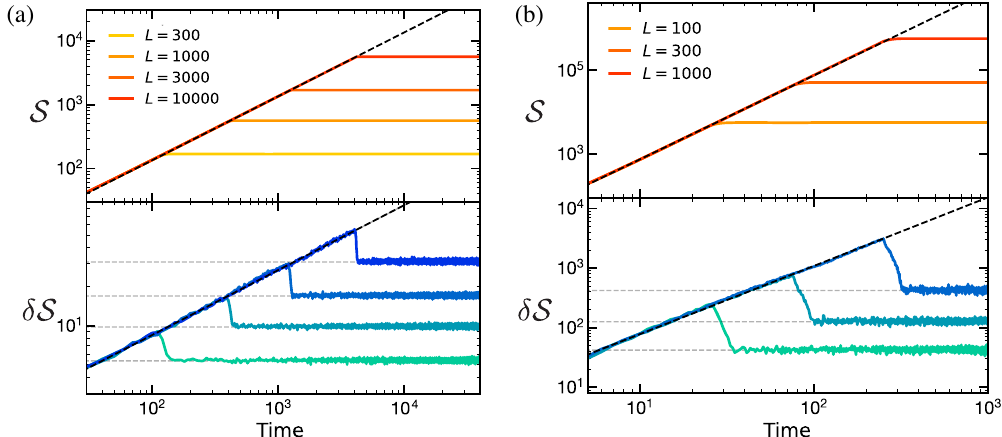
FIG. 10. Extended data for average operator size and size width in 1D (a) and 2D (b) RUCs. The average size grows ballistically ∼ t d ∼ L ∼ N 1 =d . The size width matches the predictions from the KPZ universality class (dashed lines) and (dashed line) and saturates at t scr allows us to extract the prefactors in Eqs. (56) and (57). In particular, we determine α and α and β from the initial growth rate (dark boundary boundary